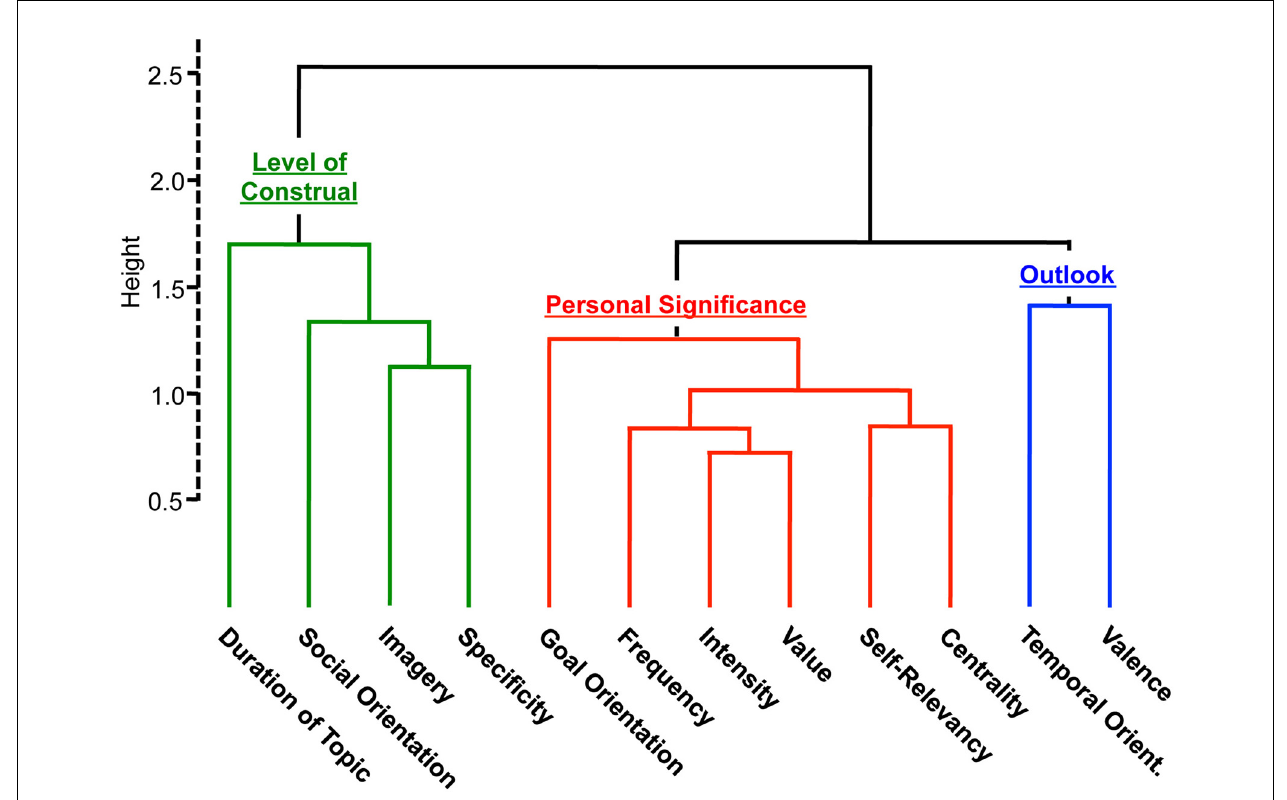
for the Outlook cluster correspond to thoughts rated as more positive and future-oriented. On the y -axis, height is a measure of similarity or distance between content variables such that two variables forming a single cluster at a small height are more similar than two variables linked at a greater